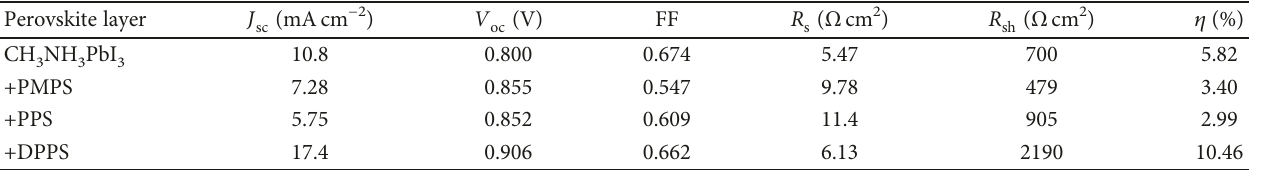
NH PbI solar cells with polysilanes. 3 3 3